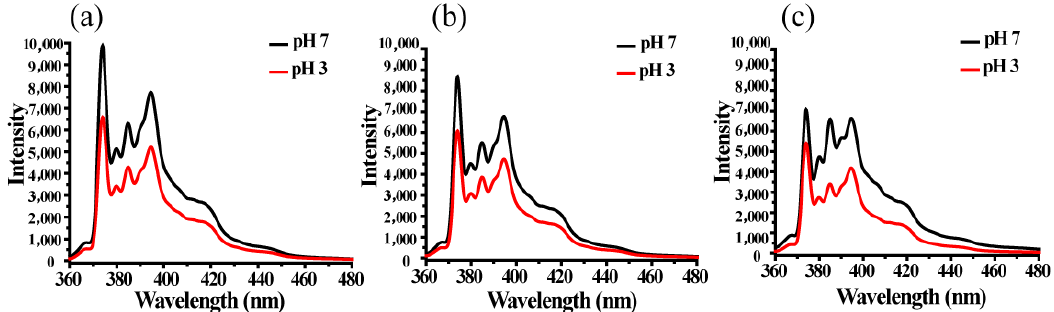
Figure 7. The fluorescent spectra of the micellar solution under different pH values: ( a ) BCP1; ( b ) BCP2; ( c ) BCP3.